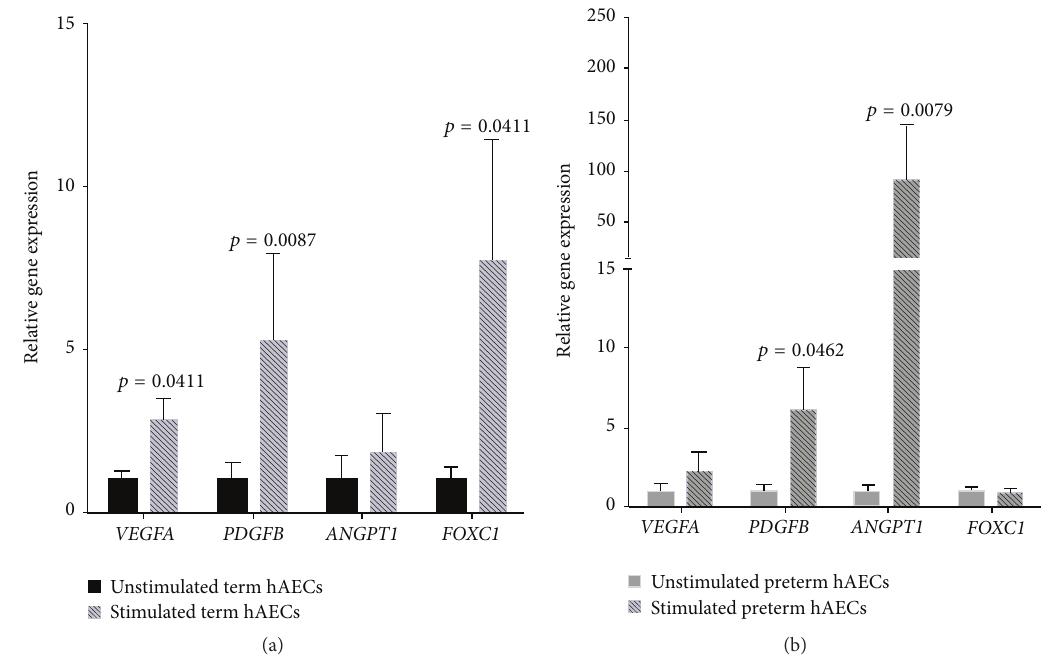
Figure 2: Gene expression of angiogenic ligands by hAECs following stimulation with TNF 𝛼 and IFN 𝛾 . (a) Gene expressions of VEGFA ( 𝑝 = 0.0411 ), PDGFB ( 𝑝 = 0.0087 ), and Foxc1 ( 𝑝 = 0.0411 ) increased in term hAECs. (b) Gene expression of PDGFB ( 𝑝 = 0.0462 ) and ANGPT1 ( 𝑝 = 0.0079 ) increased in preterm